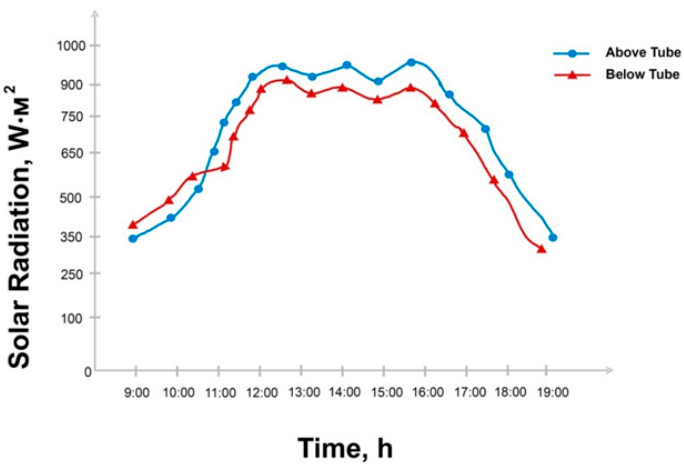
Figure 6. Changes in the intensity of solar radiation over time.